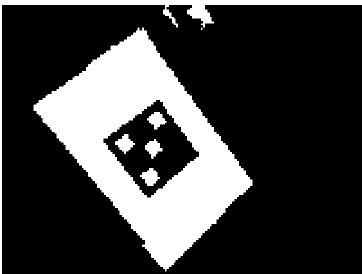
Figure 6 After filter by pixel number.